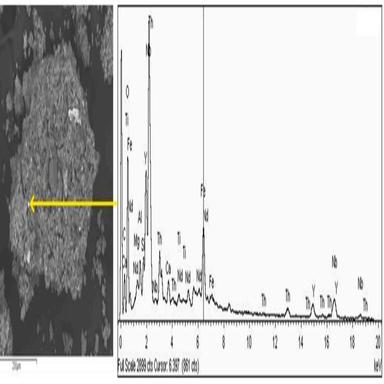
ESEM-EDX measurement of a sample from Fen-Gruveåsen. The EDX spectrum (right) originates from the bright spot indicated by the arrow in the backscattered electron image (left).